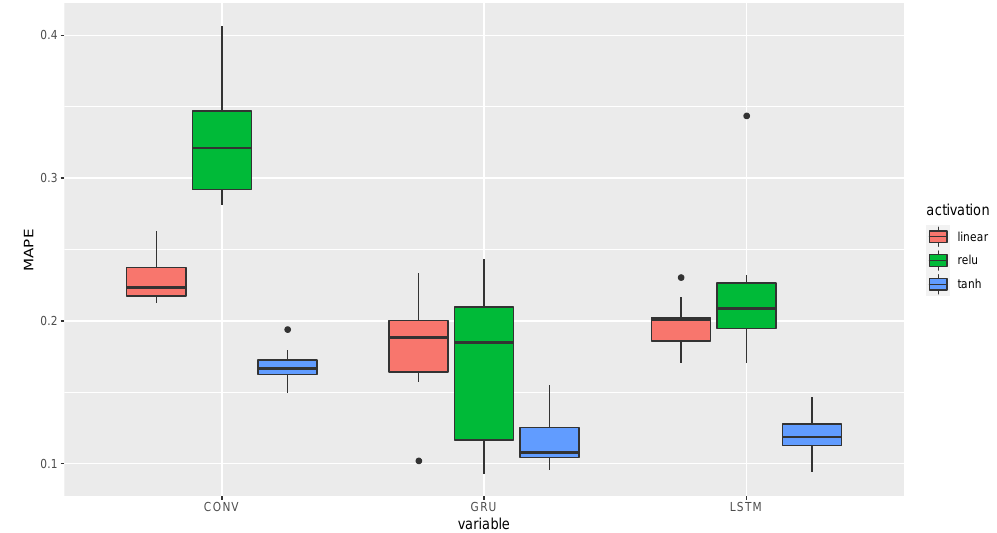
Figure 5. Forecasting MAPEbox plots for CONV, GRU, and